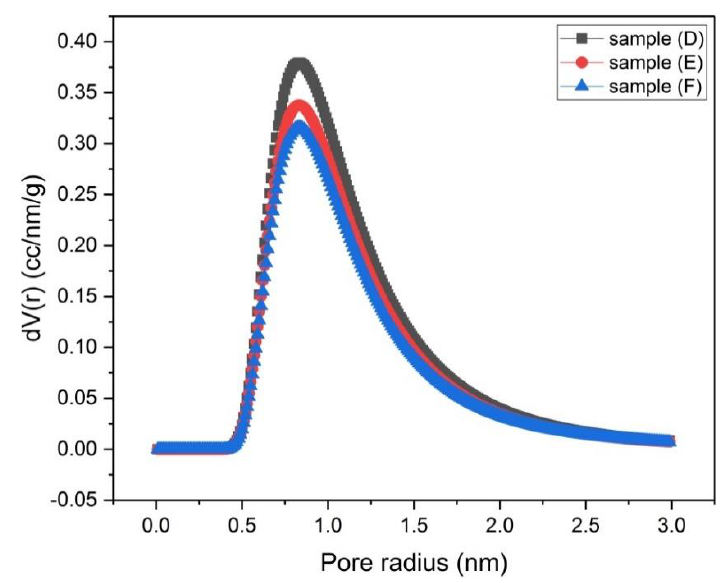
Figure 9. Micropore size distribution by the DA method for samples (D), (E) and (F).